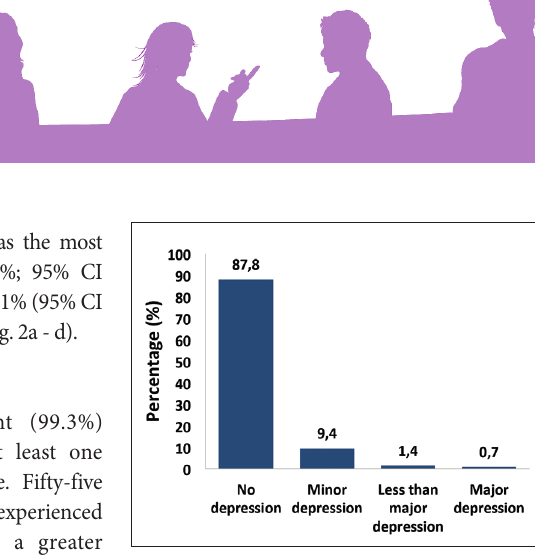
Fig. 3. HAMD scores of subjects upon entry in the